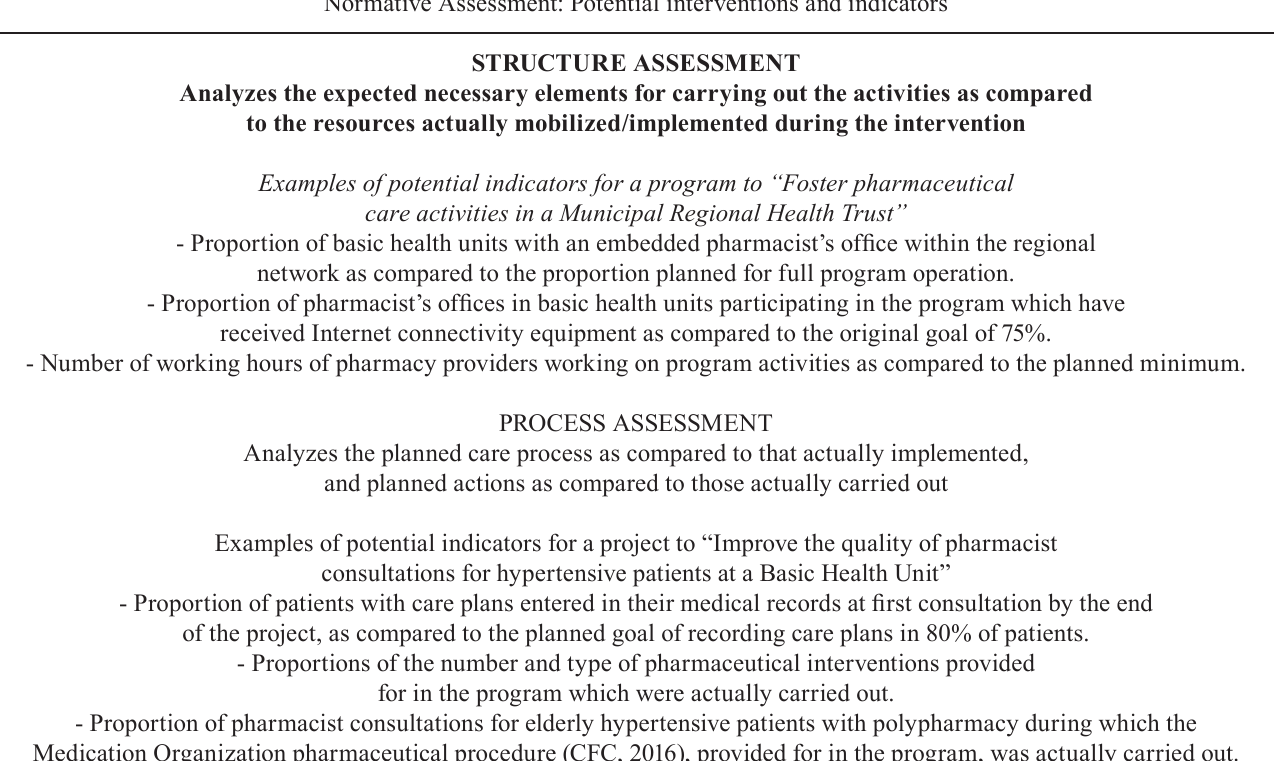
TABLE I - P ossible indicators for normative assessment and evaluative research of pharmaceutical care interventions in the selected problem